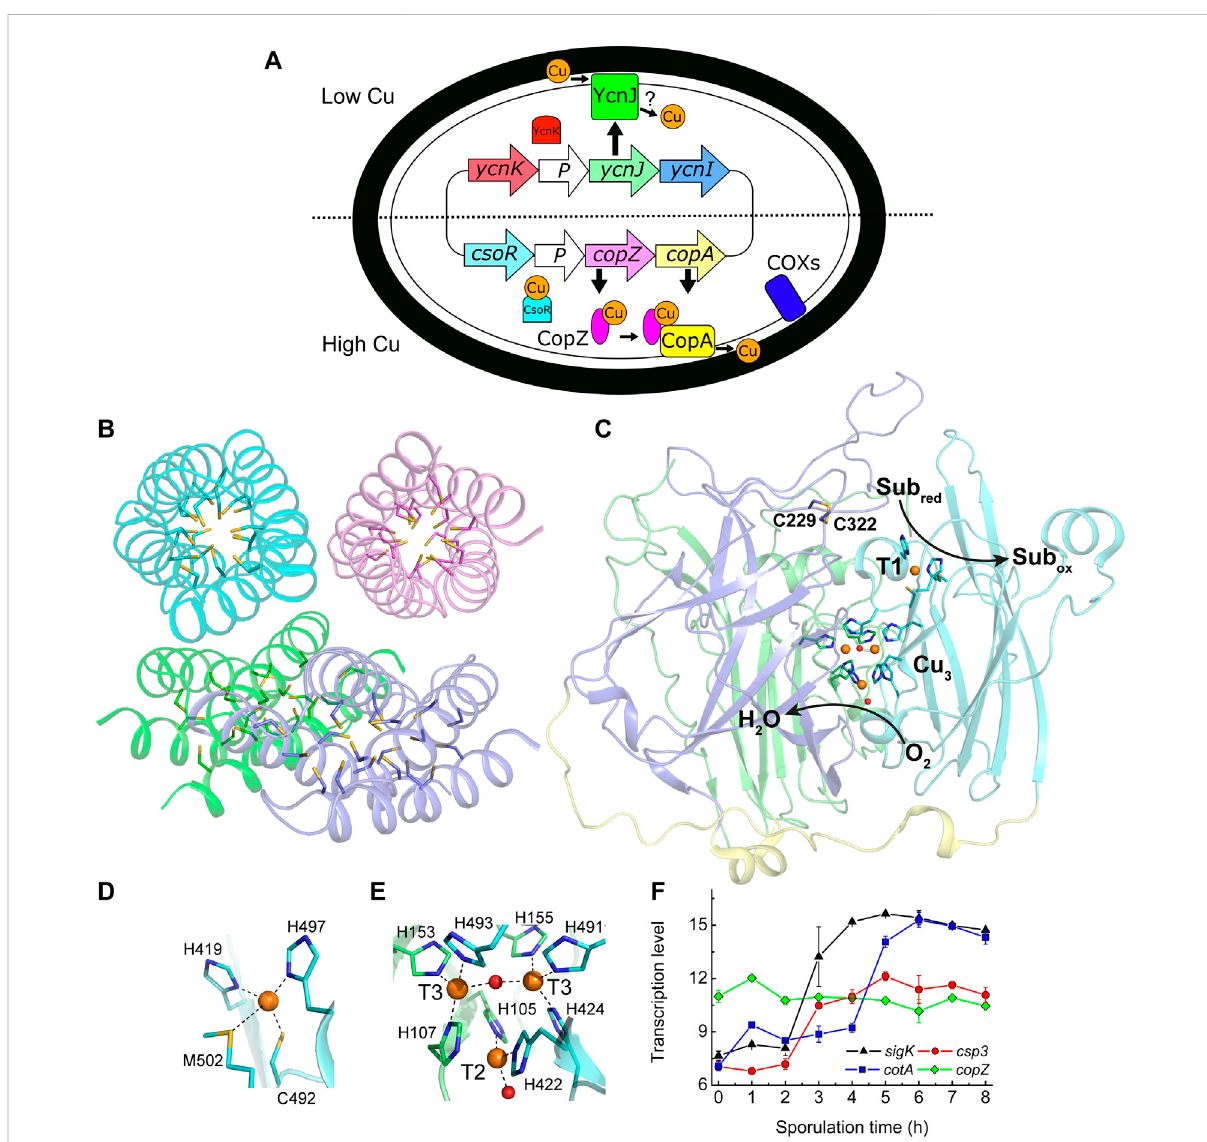
FIGURE 1 Copperhandling,acytosolicCu(I)storageprotein,aCu-requiringenzyme,andtheirtranscriptionduringsporulationin B.subtilis . (A) Anoverviewof Cu homeostasis in B. subtilis including Cu (orange circles, oxidation state unde fi ned) export by CopA and CopZ (regulated by CsoR) (Smaldone and Helmann 2007), and import by YcnJ (regulated by YcnK) (Chillappagari et al., 2009; Hirooka et al., 2012). YcnI is membrane bound and binds Cu(II) invitro , but its rolein Cuhomeostasisisunclear (Damle etal.,2021).The onlycurrentlyknown Cu-requiringenzymesinvegetative B.subtilis cells are two cytochrome oxidases(COXs)located onthe plasma membrane(Lauraeus et al., 1991). (B) The crystalstructure ofCu(I)-free Bs Csp3(PDB: 5FIG),atetrameroffour-helixbundleseachwith19Cysresiduespointingintotheircoresenablingthebindingofupto~20Cu(I)ionspermonomer(Vita et al., 2016). (C) The crystal structure of the endospore multi-Cu oxidase (a laccase) Bs CotA (PDB: 1GSK, Enguita et al., 2003) with domains 1, 2, and 3colouredgreen,slateandcyan,respectively(thelinkingregionsareyellow).Substratesareoxidized(Sub red toSub ox )attheT1Cucentrewithelectrons passed to the T2/T3 trinuclear (Cu 3 ) cluster where oxygen is reduced to water. Also highlighted is the disul fi de bond between Cys229 and Cys322. DetailedviewsoftheT1Cusite (D) andtheCu 3 cluster (E) areshown.Thesidechainsofcoordinatingresiduesarerepresentedassticks,Cuionsasorange spheres and the oxygen atoms of water (bound to the T2 Cu) and hydroxide (bridging the T3 Cu ions) ligands as red spheres in (C – E) . (F) Transcription pro fi les (Nicolas et al., 2012) of the sigK ( σ K , which facilitates expression of outer and inner spore coat proteins, black triangles), csp3 (red circles), cotA (blue squares) and copZ (green diamonds) genes during